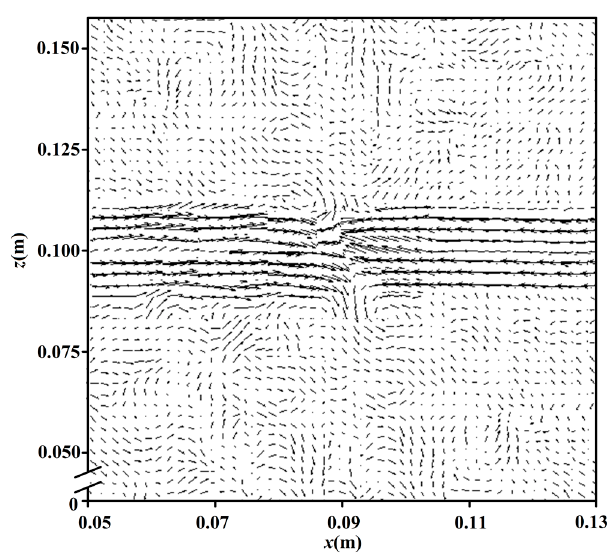
Figure 7. Instantaneous vector maps of the xz plane by PIV with a constant inlet velocity of u m = 1.25 m/s and L / D = 4.